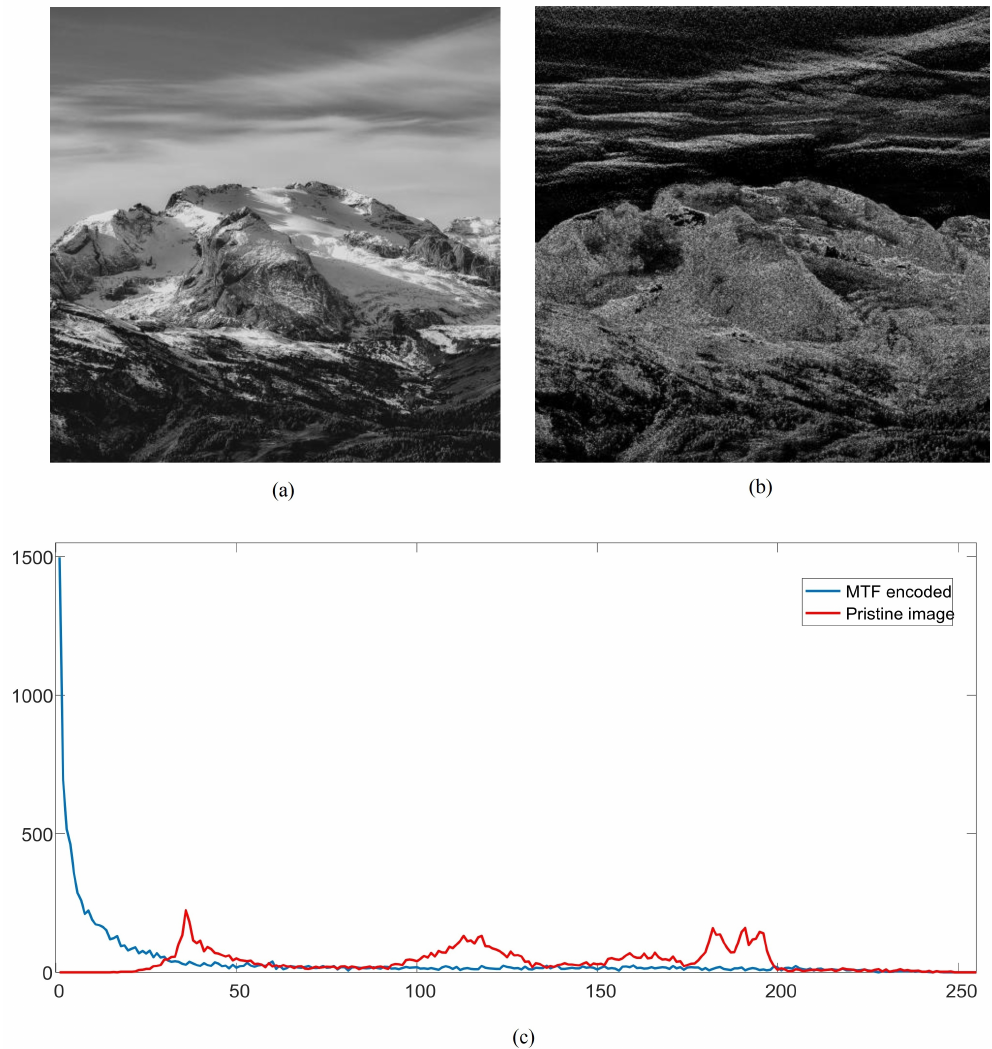
Figure 11. ( a ) Original image [58] ( b ) MTF encoded image ( c ) Histogram of original image and its MTF encoded